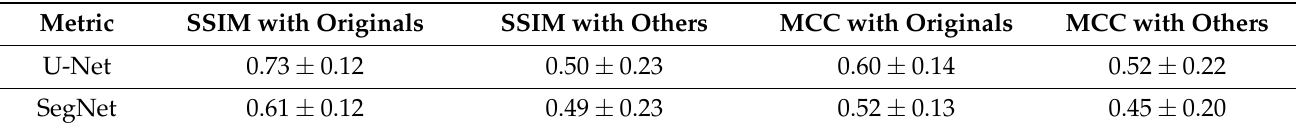
Table 2. Comparison between the mean SSIM and MCC scores of the reconstructed images with the true original images and corresponding mean scores of the reconstructed images with the images from all other patients in the database. Skull-stripped images were used for these experiments.